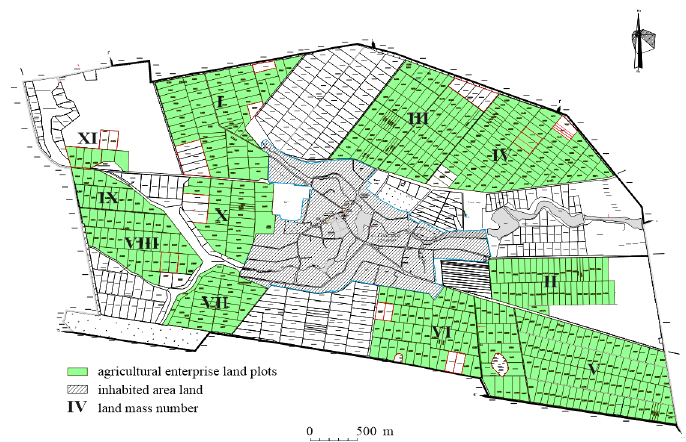
Figure 10. Land consolidation through land plots exchange (option І)